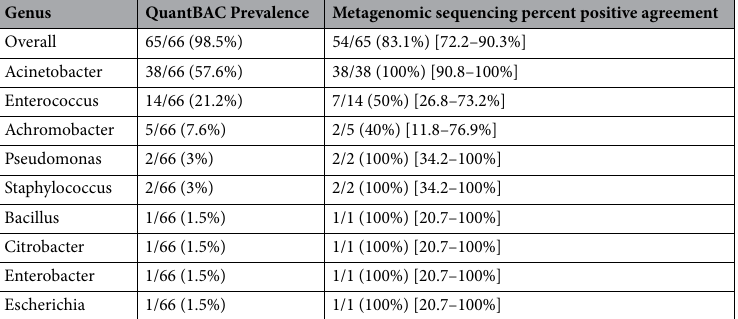
Table 1. Concordance between microbial genus-level detection by quantitative bacteriology and metagenomic sequencing. Concordance was assessed according to prevalence, with positive percent agreement estimates used to compare genus detection from metagenomic sequencing to quantitative bacteriology, applied here as a non-reference standard. Note: except for one case, these tests did not have a Negative result to